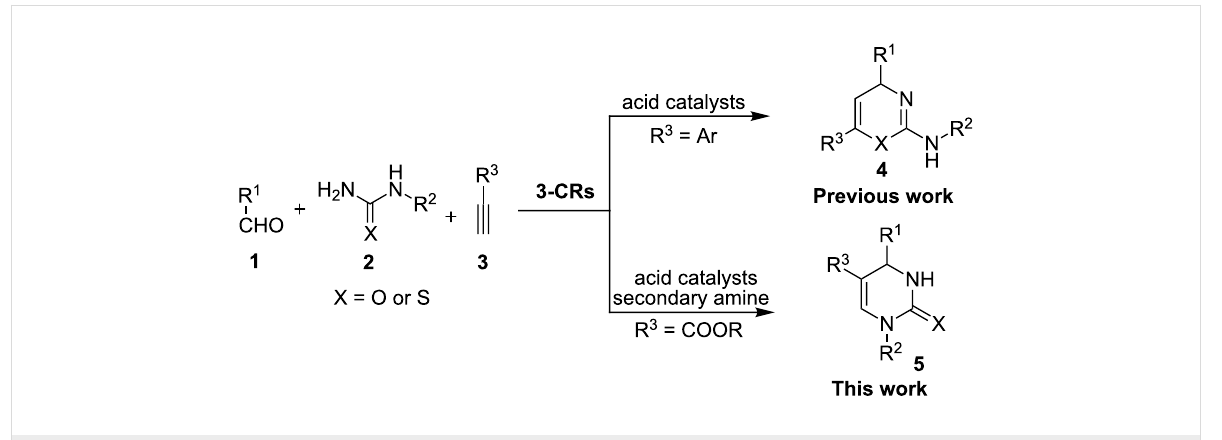
Scheme 1: Regioselective 1,3-thiazines and DHPMs via aldehydes, ureas/thioureas and alkynes.